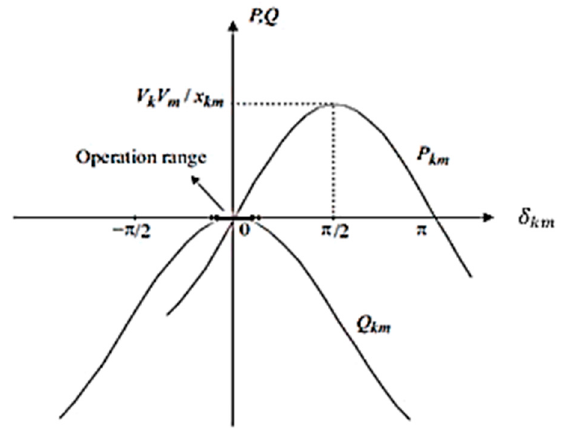
Figure 4. P– δ and Q– δ curves.